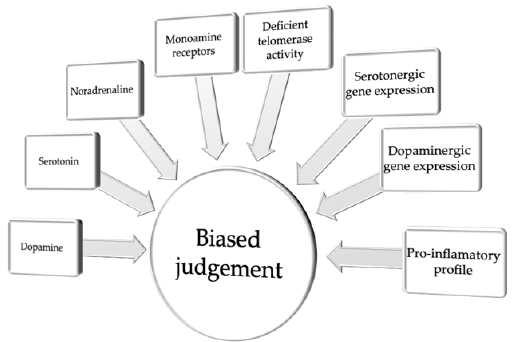
Figure 1. Neuromolecular and cellular correlates of biased judgment.